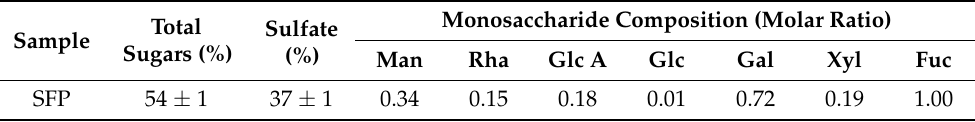
Table 1. Chemical composition of the SFP.